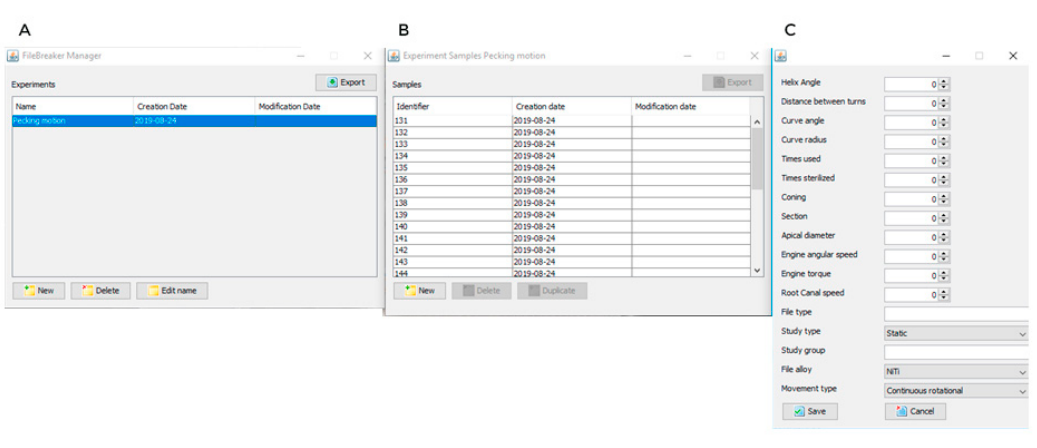
Figure 3. The management software ( A , B ) that managed the cyclic fatigue device with configurable parameters ( C ).